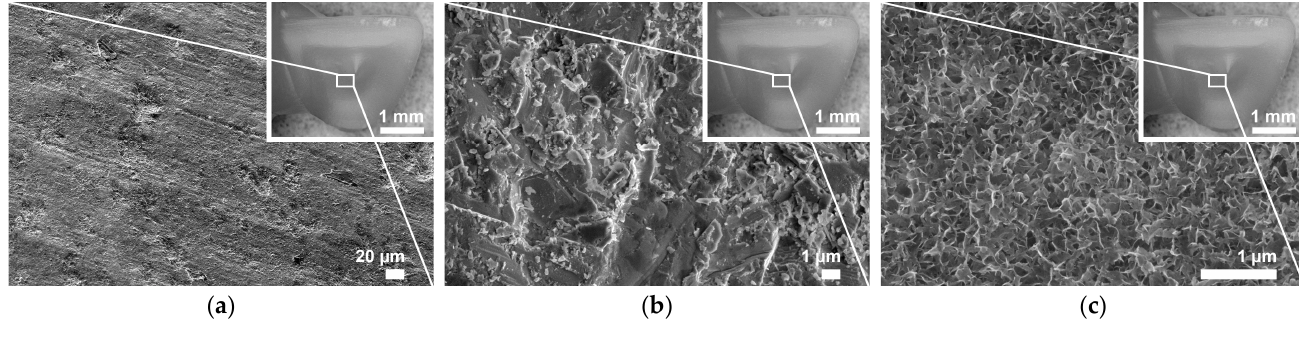
Table 1. Load-bearing capacity means and standard deviations (SD), in Newtons, of the experi- mental groups after quasi-static loading. The same upper-case le tt ers in each column denote no statistical di ff erences ( p < 0.05). * denotes statistically signi fi cant di ff erence between LBC values of non-aged and aged subgroups of the same experimental group.